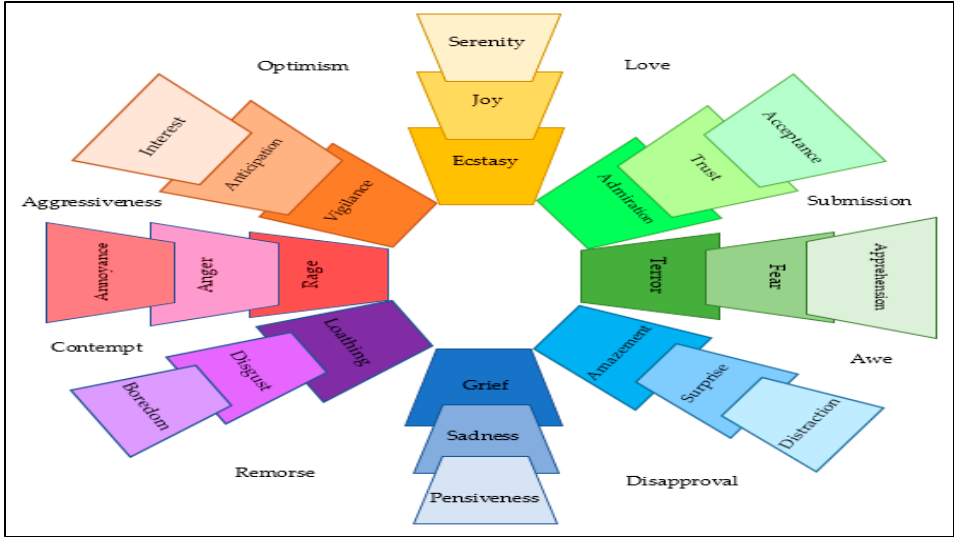
Figure 4. The Plutchik wheel of emotion [33], (This wheel divided into twenty-four primary, secondary, and tertiary dyads that represents the eight emotions of joy, trust, fear, surprise, sadness, disgust, anger, and anticipation).